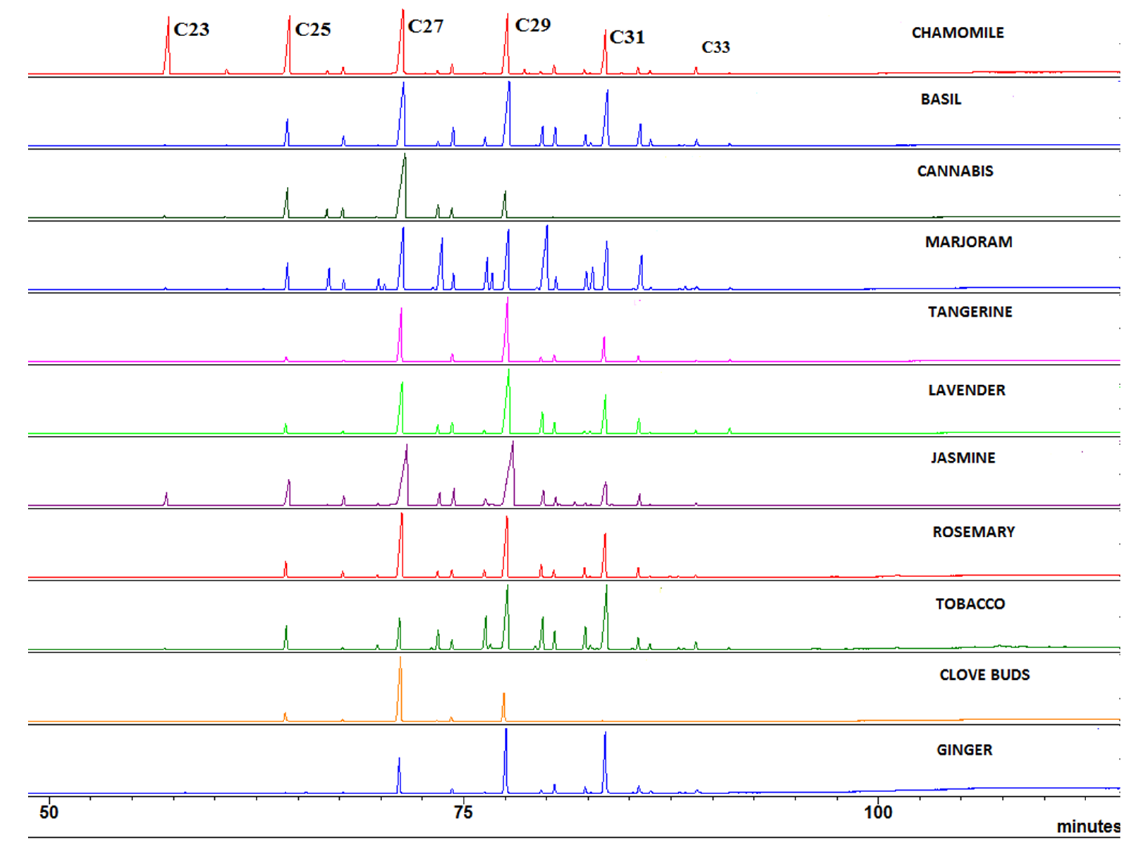
Figure 2. Comparison of GC − MS traces of cuticular waxes extracted by SC − CO 2 plus fractional separation from different vegetable matter, studied in this work.